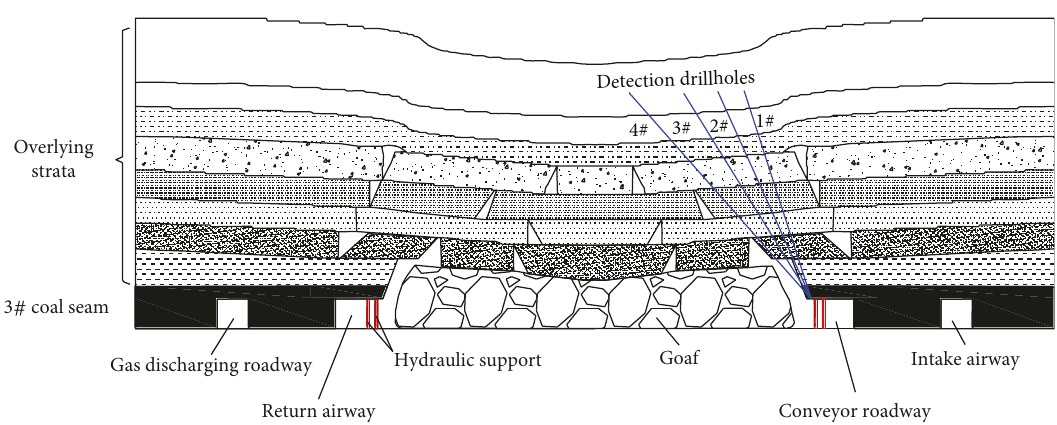
Figure 7: Schematic diagram showing endoscopic detection drilling-boreholes designed in N1102 working face. Table 4: Construction parameters of endoscopic detection